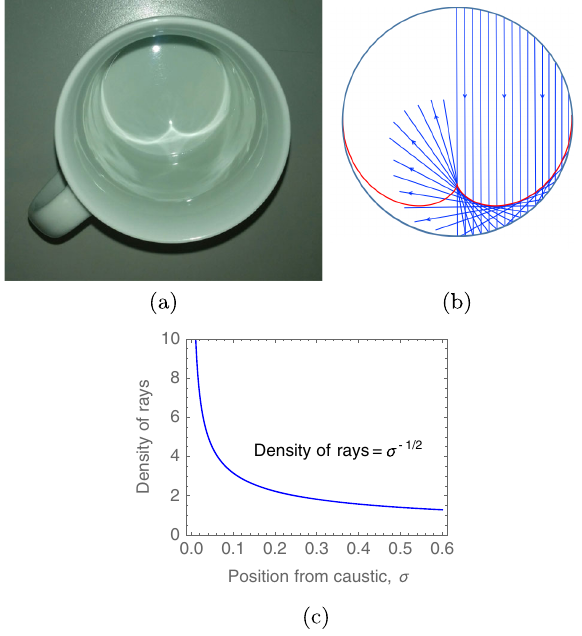
FIG. 1. Optical caustics, which are analogous to electron – trajectory caustics found in accelerator physics. (a) image of caustic lines appearing in a coffee cup. (b) illustration of light rays forming the caustic (red line), and (c) intensity of the rays in the vicinity of the